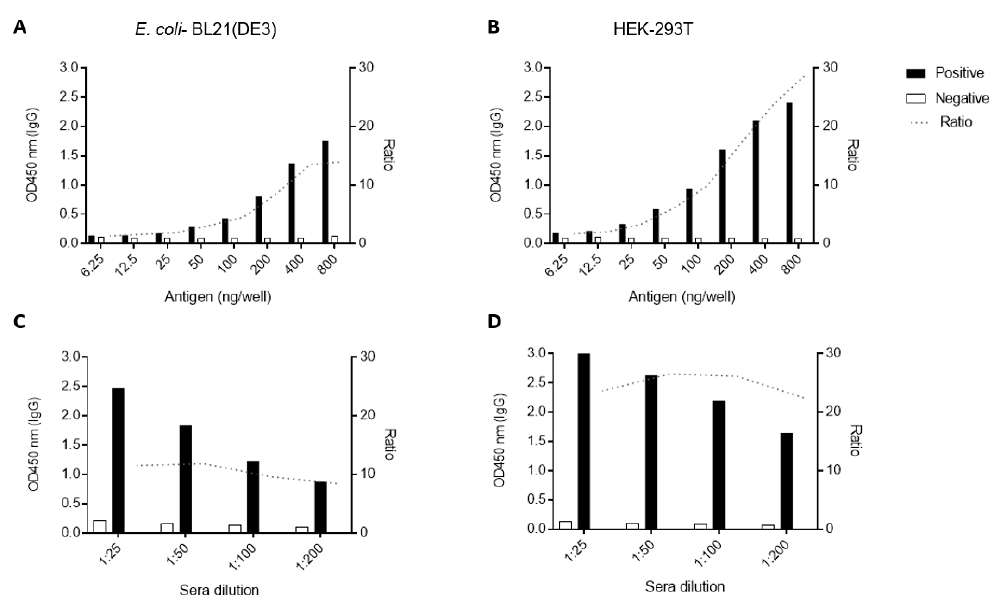
Figure 3. Standardization of the Indirect IgG ELISA to detect antibodies against CHIKV. Different amounts (titer) of antigens ( A , B ) and different pooled sera dilutions ( C , D ) were tested in the Indirect ELISAs to determine minimum optimal antigen concentrations and maximum optimal sera dilution. Graphics at the left show the results for CHIKV-E2 produced in E. coli and at the right show results using the eukaryotic recombinant antigen.